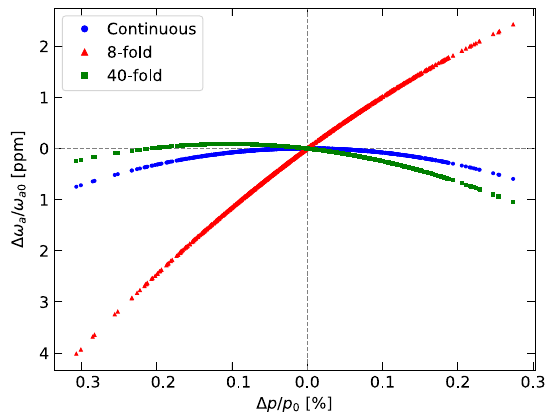
FIG. 7. The spin precession frequency relative to the reference, Δ ω = ω , in the combined magnetic and electric focusing storage a a 0 ring with 5 GeV = c muons from numerical simulations. The magnetic and electric field indices were given such that the dispersion correction C is suppressed. Different colors represent d different lattice configurations for the focusing elements: (blue) continuous focusing elements around the ring, (red) discrete 8-fold and (green) 40-fold alternating